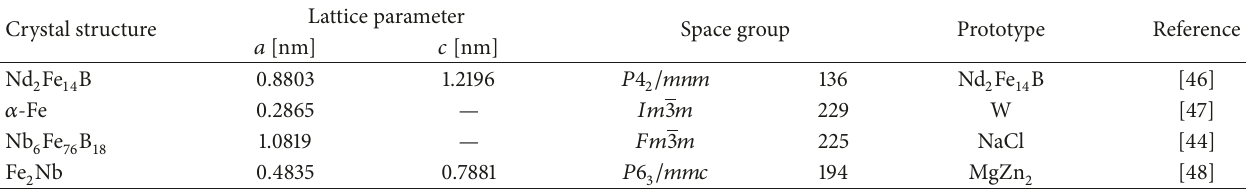
Table 1: Crystal structure and lattice parameters of identified phases in the large grained nanocomposite Nd-Fe-B melt-spun ribbon. Crystal structure